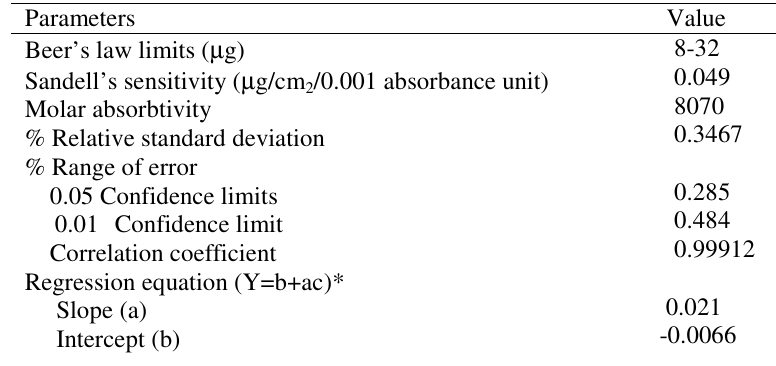
Table 1. Optical characteristics